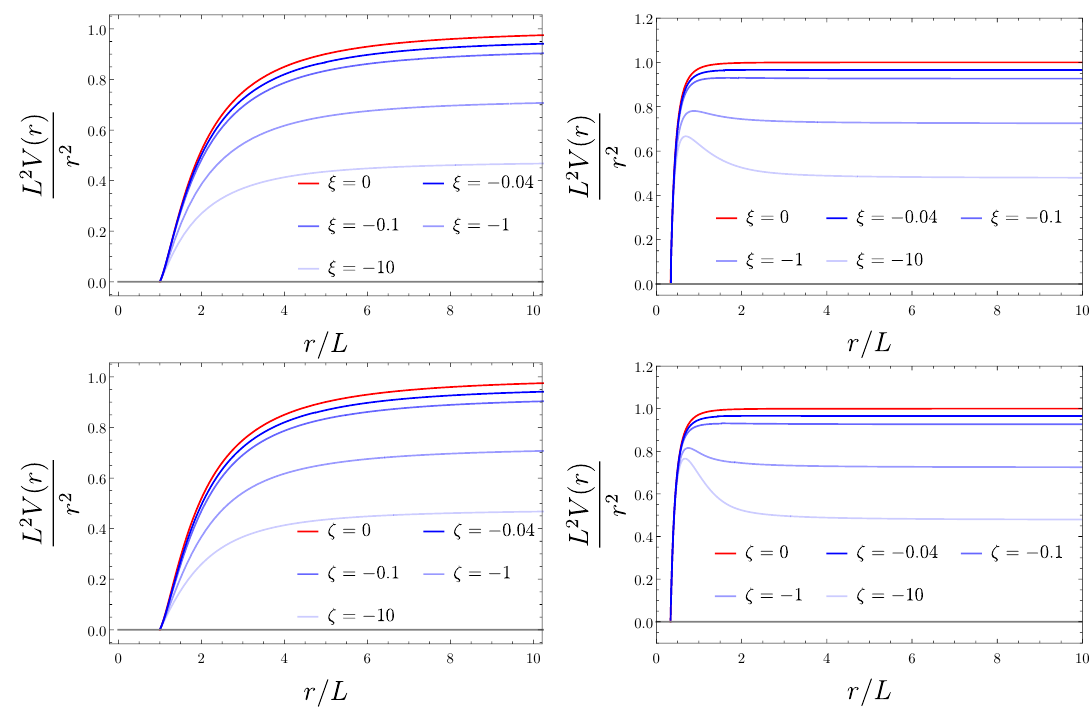
Figure 9 . The metric function L 2 V CP 2 ( r ) =r 2 is plotted for NUT solutions of the quartic theories. The top row depicts solutions of the quartic generalized quasi-topological theory with n=L = 1 (left) and n=L = 1 = 3 (right). The solutions with n=L = 1 all have positive mass, while those with n=L = 1 = 3 have negative mass. The bottom row depicts solutions of the quartic quasi-topological theory with n=L = 1 (left) and n=L = 1 = 3 (right). The solutions with n=L = 1 all have positive mass, while those with n=L = 1 = 3 have negative